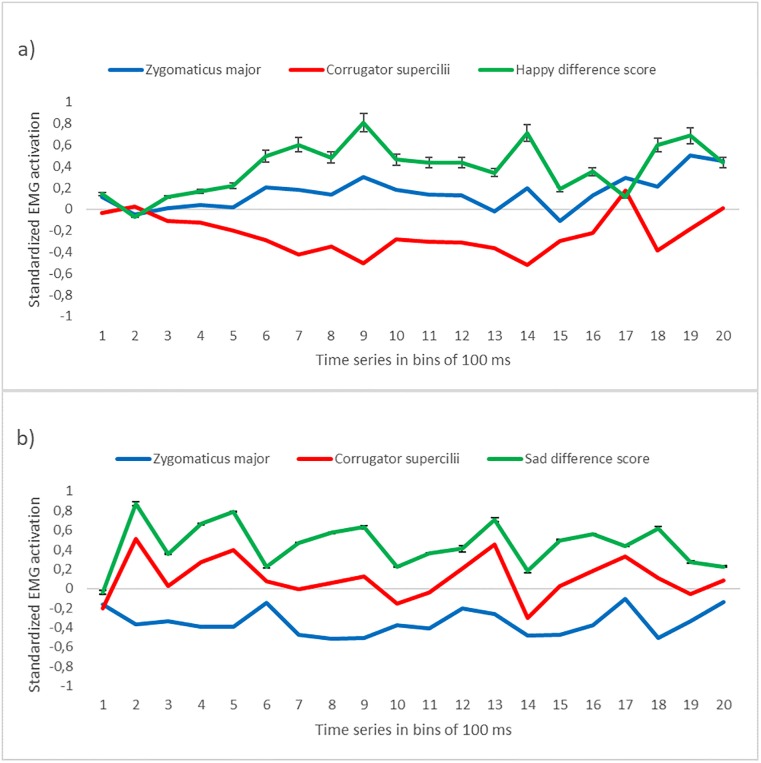
EMG time course activation plots.Time course of standardized EMG activation of the corrugator supercilii (red) and zygomaticus major (blue) muscles, in response to happy (a) and sad (b) stimuli in bins of 100 ms from stimulus onset (0 ms) to stimulus offset (2000 ms). The green line represents the difference score between the two muscles for happy (a) and sad (b) stimuli in which each bin represents the mean (with the standard error) amplitude over 100 ms time.